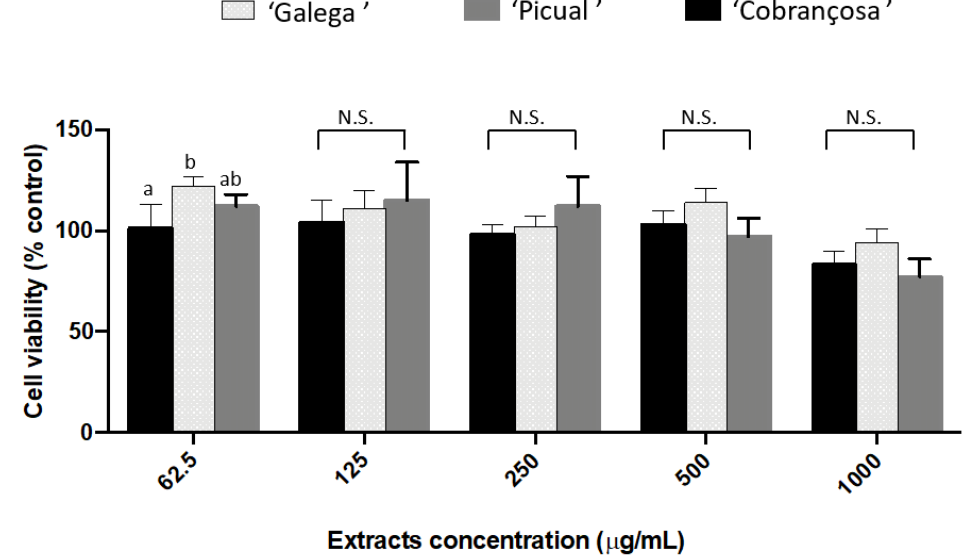
Figure 2. Cytotoxic effect of the olive seeds methanol extracts on SH-SY5Y cells. Data presented as mean ( n = 3) ± SD values for the same parameter evaluated followed by different superscript lowercase letters are significantly different at p < 0.001, according to Tukey’s test. N.S.: not significant.